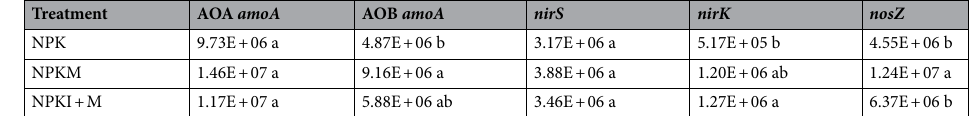
Table 3. Ammonia oxidizers and denitrifier functional gene abundance (copies g −1 of dry soil). Values followed by different lowercase letters at the same column indicated significant difference (P < 0.05) among the treatments.